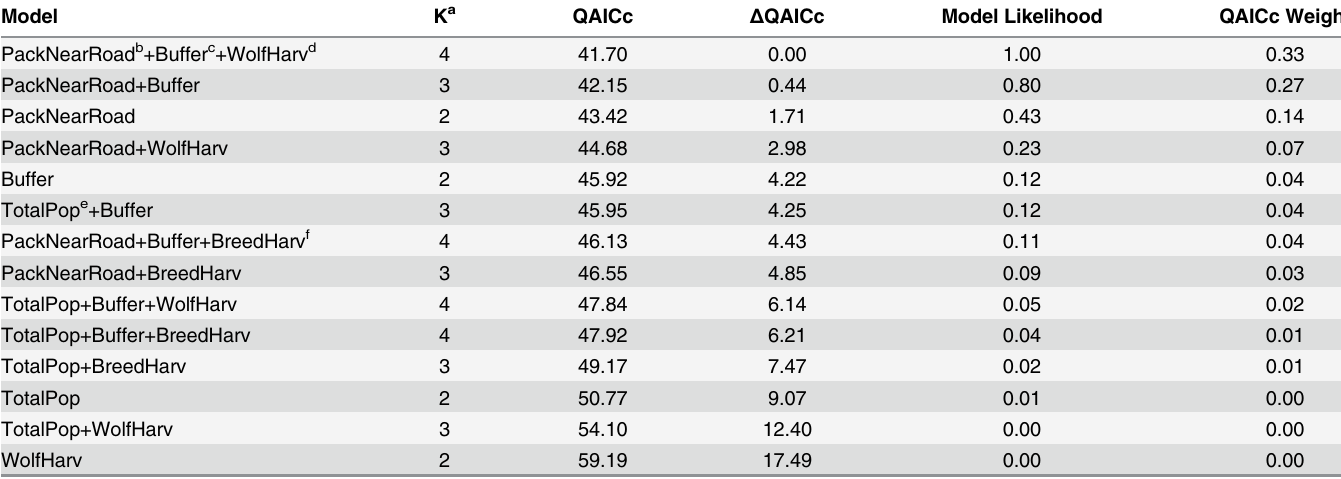
Table 3. Candidate model set and model selection criteria evaluating factors potentially affecting probability of wolf sightings along Denali Park Road in Denali National Park and Preserve, Alaska, USA.